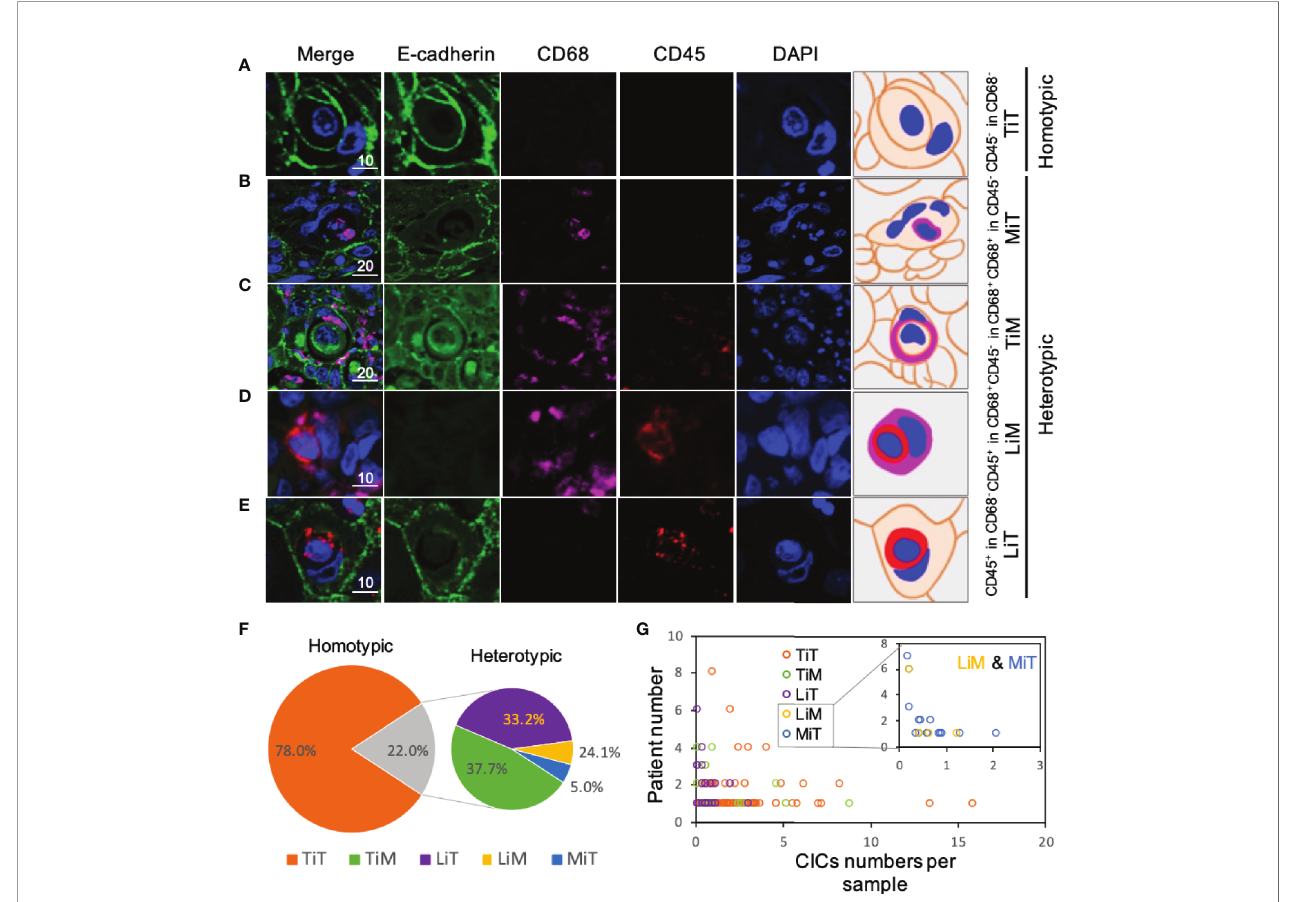
FIGURE 2 | Subtype pro fi ling of cell-in-cell structures in esophagus cancer. (A – E) Representative images for fi ve CIC subtypes as indicated. Right panels of pictures demonstrate the schematic structure for each CIC subtype. Scale bar: 10 or 20 m m. (F) Distribution of fi ve CIC subtypes across esophagus cancer tissues in all patients. (G) Distribution of fi ve CIC subtypes in esophagus cancer tissues from different